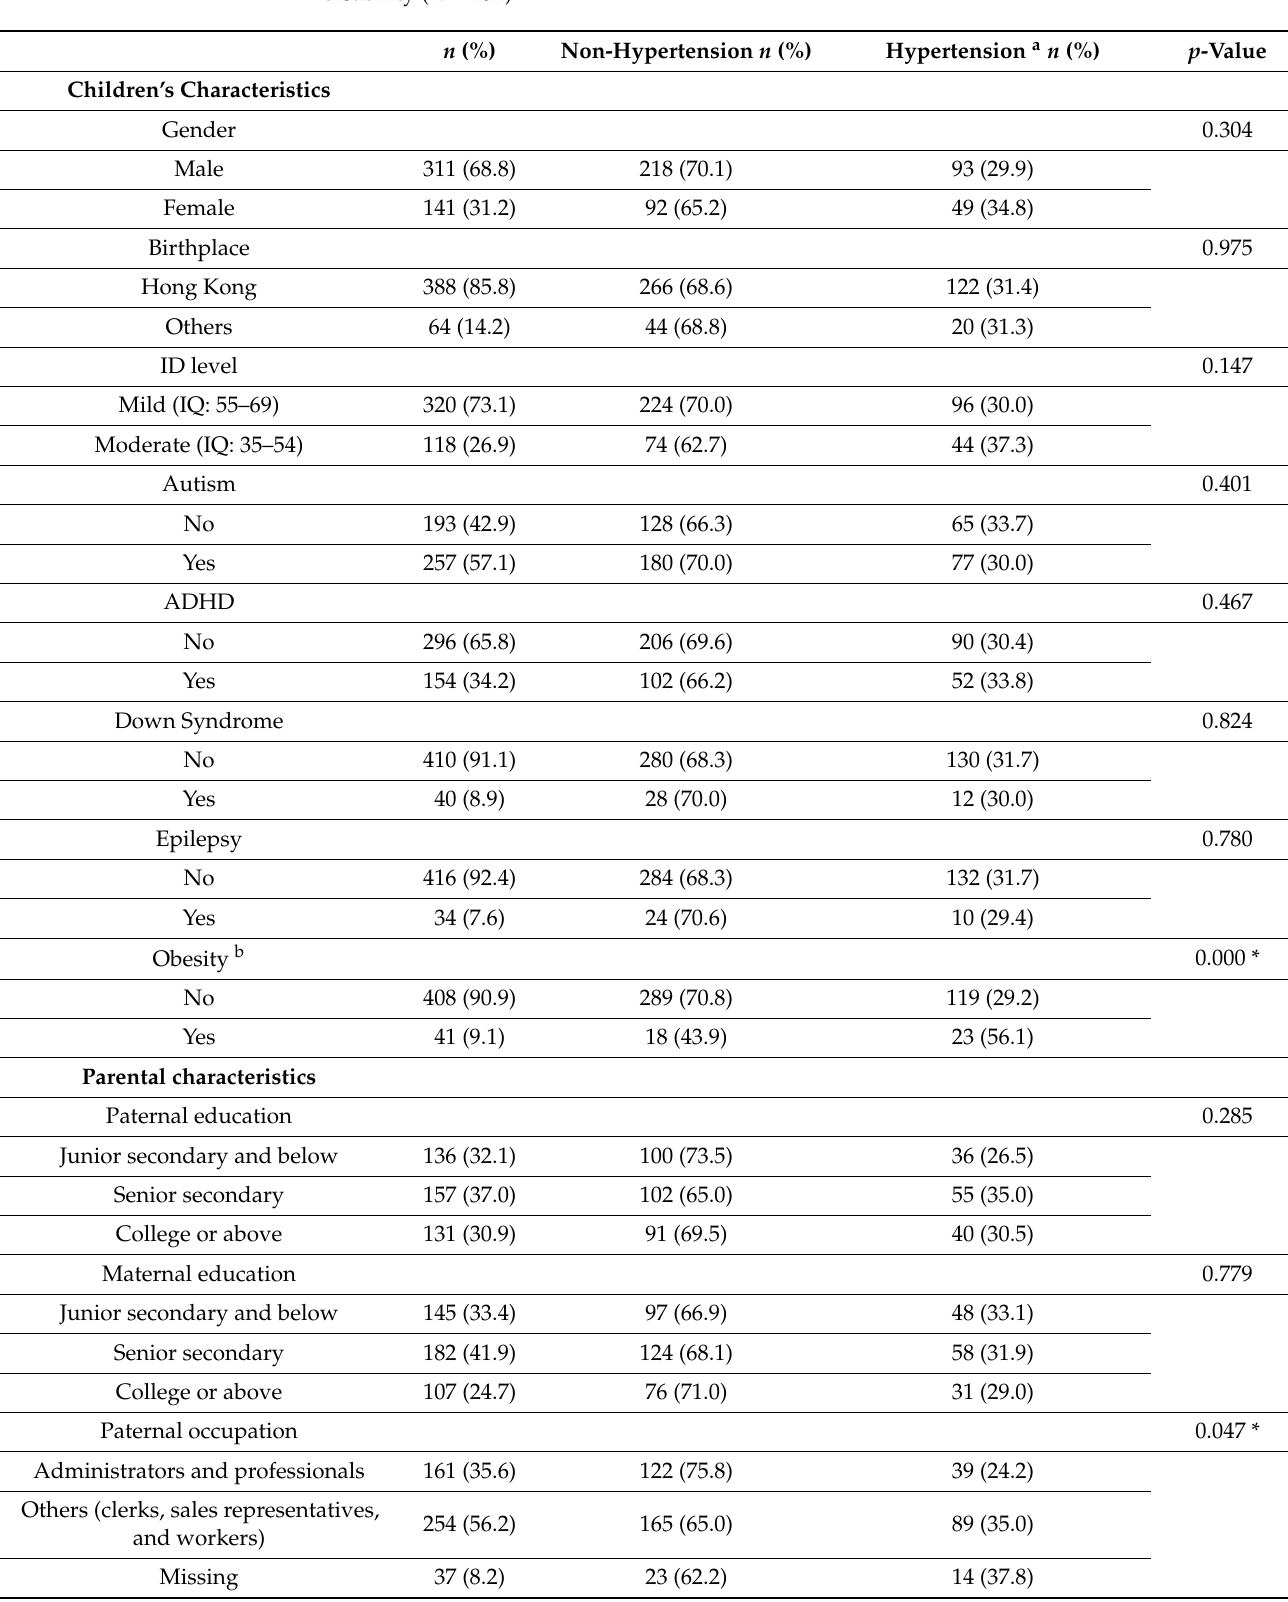
Table 1. Distribution of hypertension by background characteristics in children with